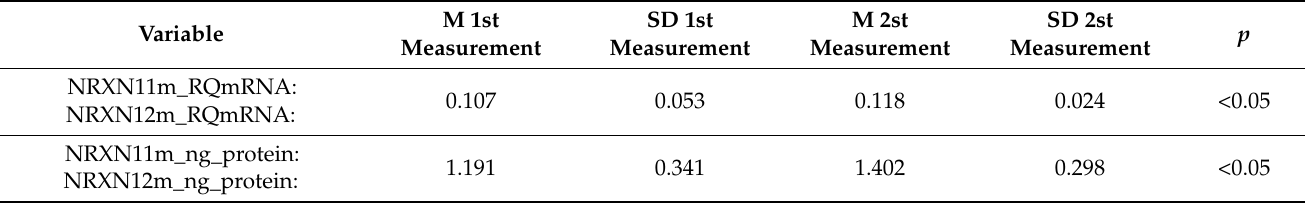
Table 3. Results of paired difference tests between the measurements of the expression of the studied gene in the experimen- tal group.